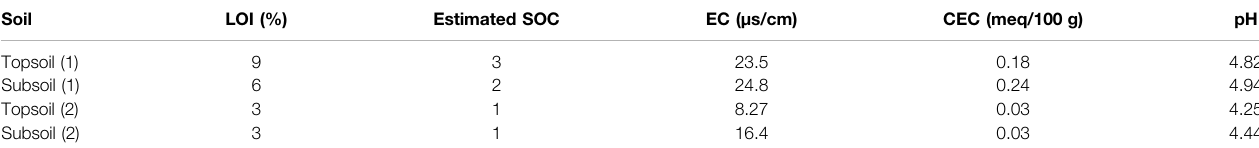
TABLE 1 | Physicochemical characteristics of the used soils. EC, electrical conductivity; LOI, loss on ignition, CEC (cation exchange capacity) and pH. Soil LOI (%) Estimated SOC